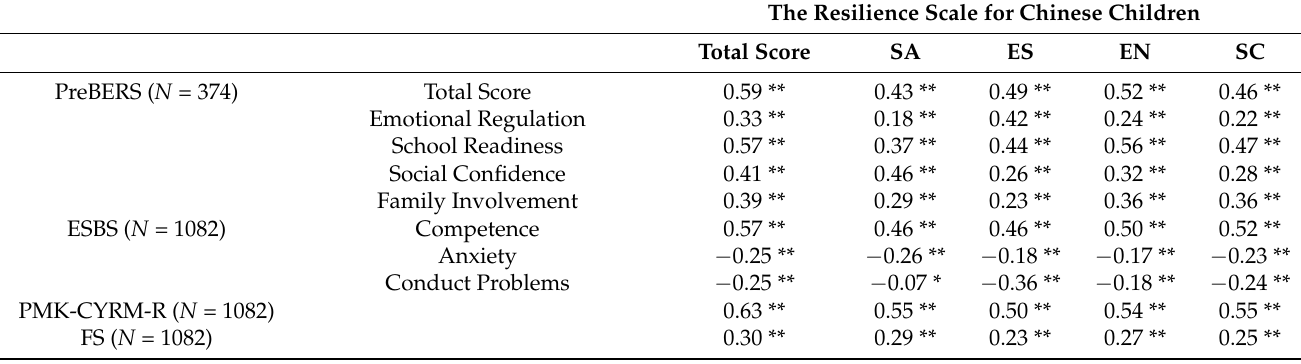
Table 5. Correlation coefficients between the four early childhood measurement scales and the Resilience Scale for Chinese Children in terms of total and subscale